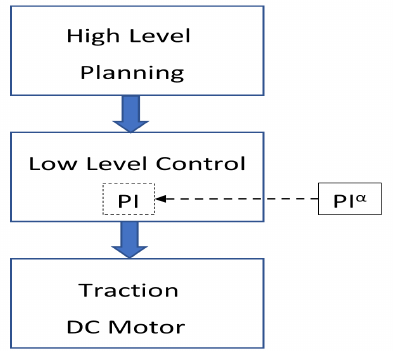
Figure 3. Overall block diagram of the autonomous